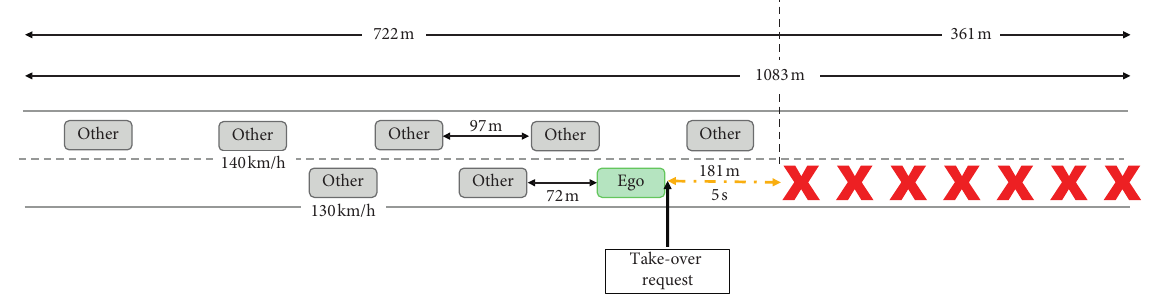
Figure 3: Road layout for Scenario 1 (time budget � 5s traffic density � medium). Table 2: Overview of the dependent